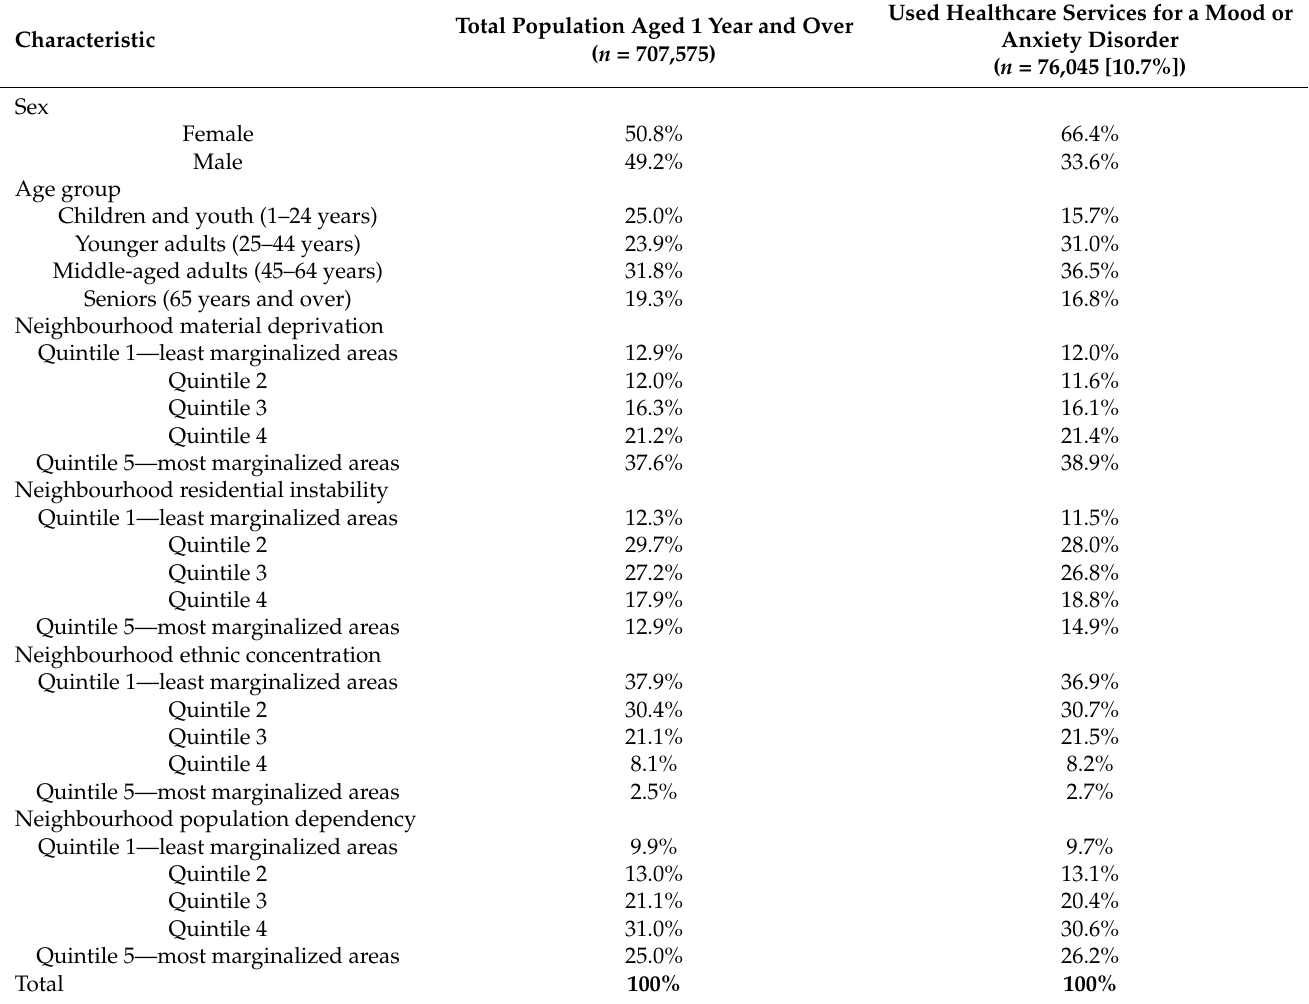
Table 1. Percentage distribution of the population aged 1 year and over by selected person- and neighbourhood-level characteristics, according to healthcare utilization for mood and anxiety disorders, New Brunswick (Canada), 2015/2016.